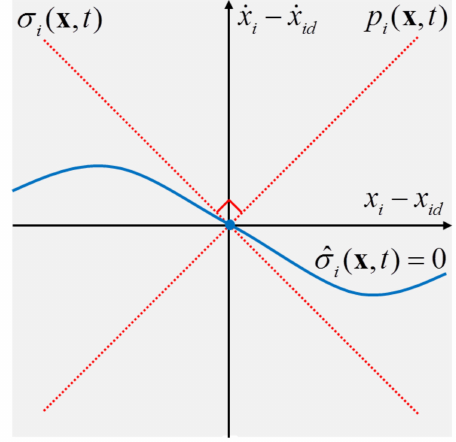
Figure 4. Nonlinear sliding surface based on a sigmoid